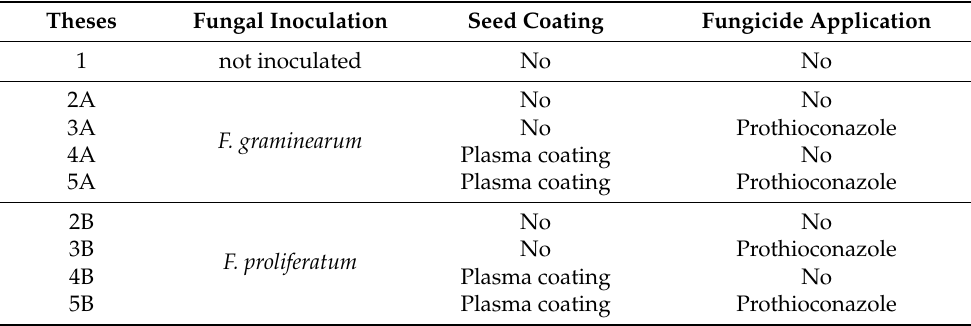
Table 1. Description of theses used for experimental assays in vitro and in planta. Theses Fungal